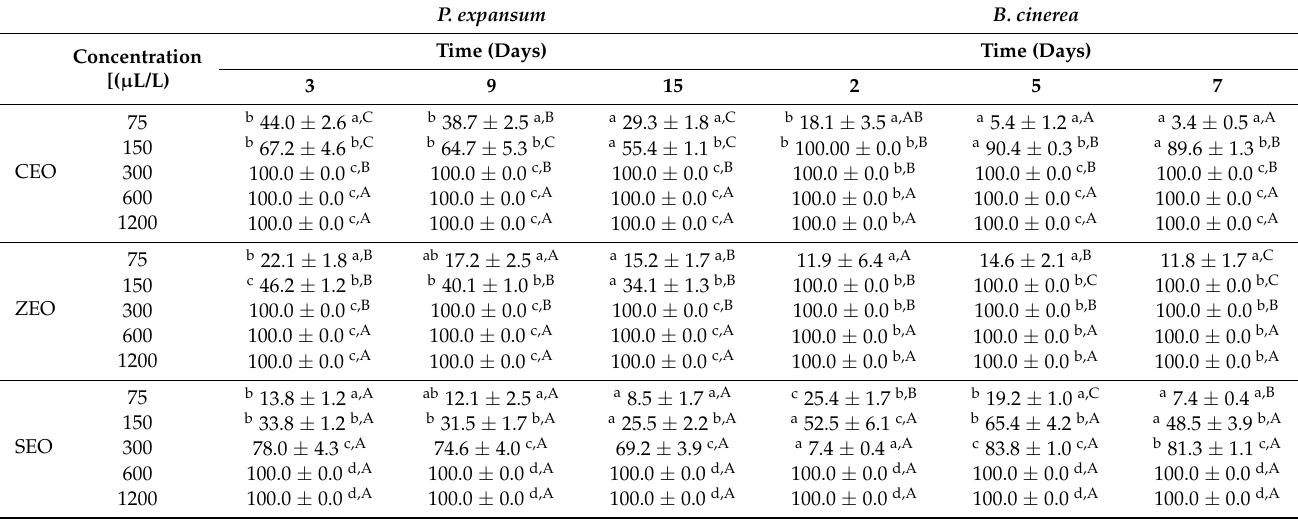
Table 1. Antifungal index (AI,%) for CEO, ZEO, and SEO treatments against P. expansum and B. cinerea (in vitro assay). For any investigated fungus, different right-side lowercase and uppercase letters within the same column denote significant differences ( p < 0.05) among AI values due to the effect of employed EO concentration and EO type, respectively. When reported, different left-side lowercase letters within the same row indicate significant differences ( p < 0.05) among AI values only due to the effect of observation